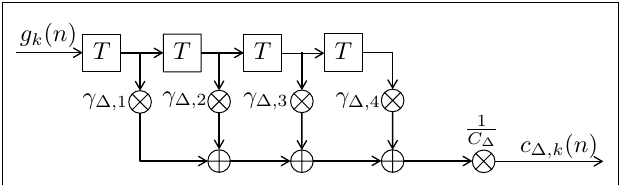
FIGURE 9 | Block diagram of the fourth-order finite impulse response (FIR) filter H (cid:49) ( f ). Elements T represent a delay of one trial, the multipliers γ (cid:49) , i compose the filter coefficients and C (cid:49) constitutes a normalizing